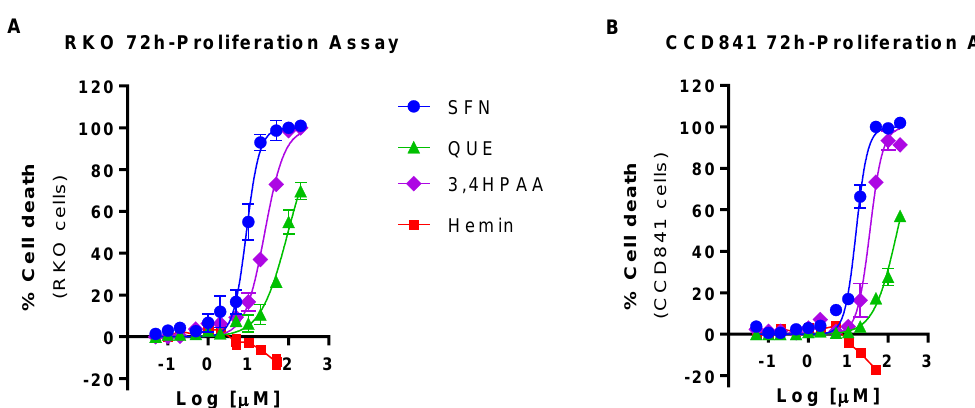
Figure 1. Effect of hemin, SFN, QUE and 3,4HPAA in cell viability. ( A ) RKO cells and ( B ) CCD841 cells were incubated with increasing concentrations of hemin (0.05–50 μM), SFN, QUE or 3,4HPAA (0.05–200 μM). After 72 h, the 3-(4,5-dimethylthiazol-2-yl)-5-(3-carboxymethoxyphenyl)-2-(4-sulfophenyl)-2H-tetrazolium) reduction was detected by absorbance (MTS assay). The results were expressed as percentage of inhibition in relation to the positive control (30 µM puromycin) and calculated as: ((OD 0.4% DMSO − OD sample ) × 100)/(OD 0.4% DMSO − OD puromycin ). Values are expressed as mean ± SEM, from three independent culture preparations. 3,4HPAA, 3,4-dihydroxyphenylacetic acid; QUE, quercetin; SFN, sulforaphane.